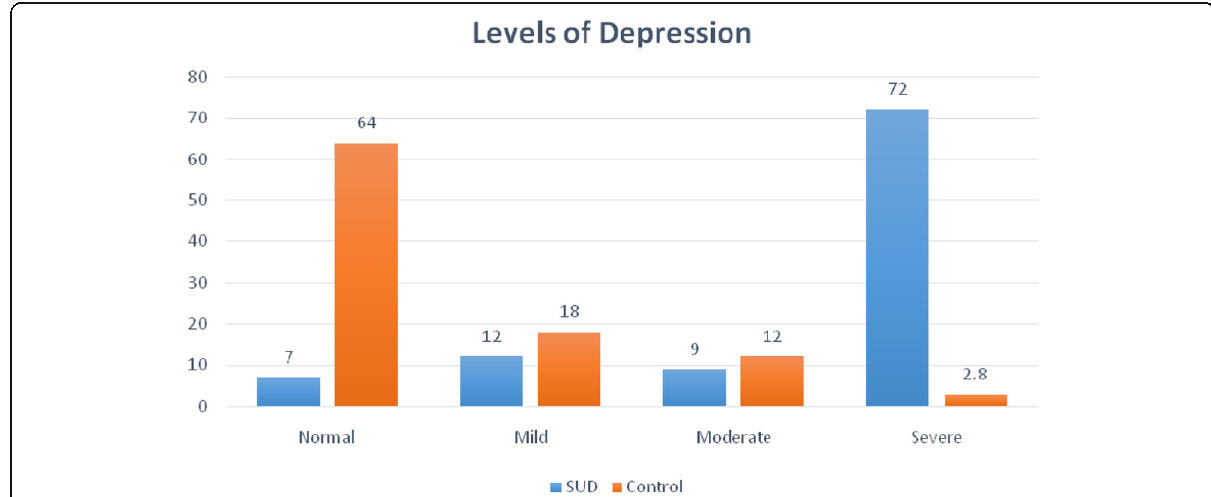
Fig. 2 Comparison between the SUD group ( n = 100) and control group ( n = 50) regarding depression levels according to the HAM-D rating